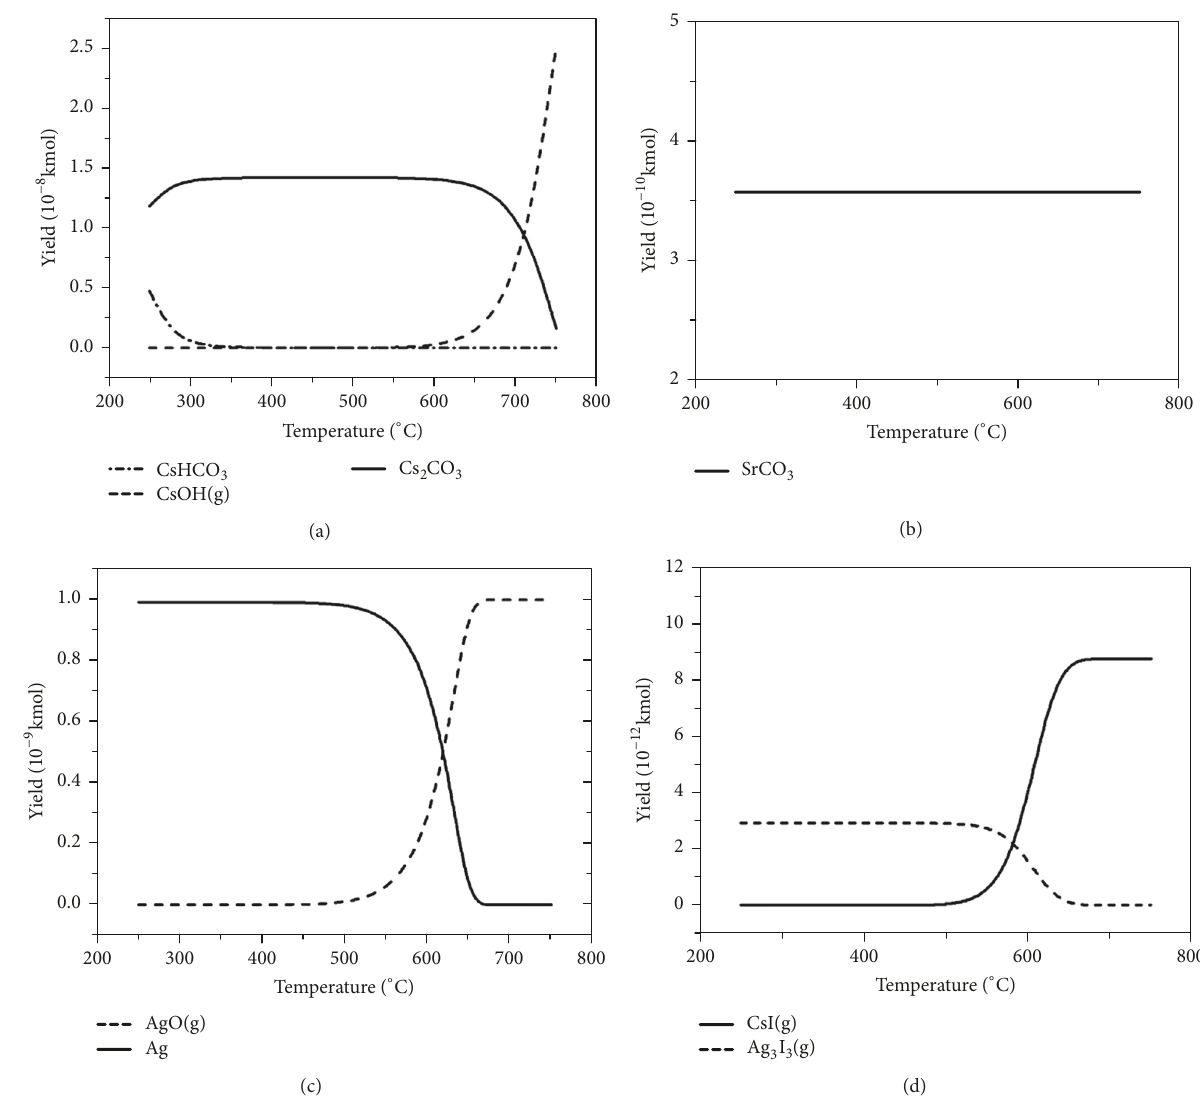
Figure 3: Variations in the amounts of each kind of compound: (a) Cs, (b) Sr, (c) Ag, (d) I.